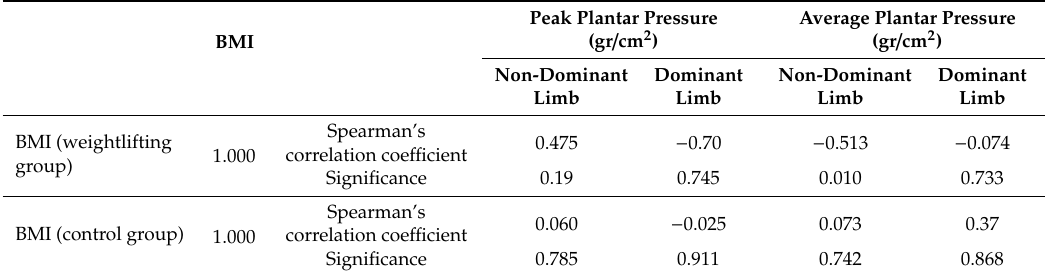
Table 4. Spearman’s rank correlation coe ffi cients of BMI (Body Mass Index) and static peak and average plantar pressure of the dominant and non-dominant limb in both groups.